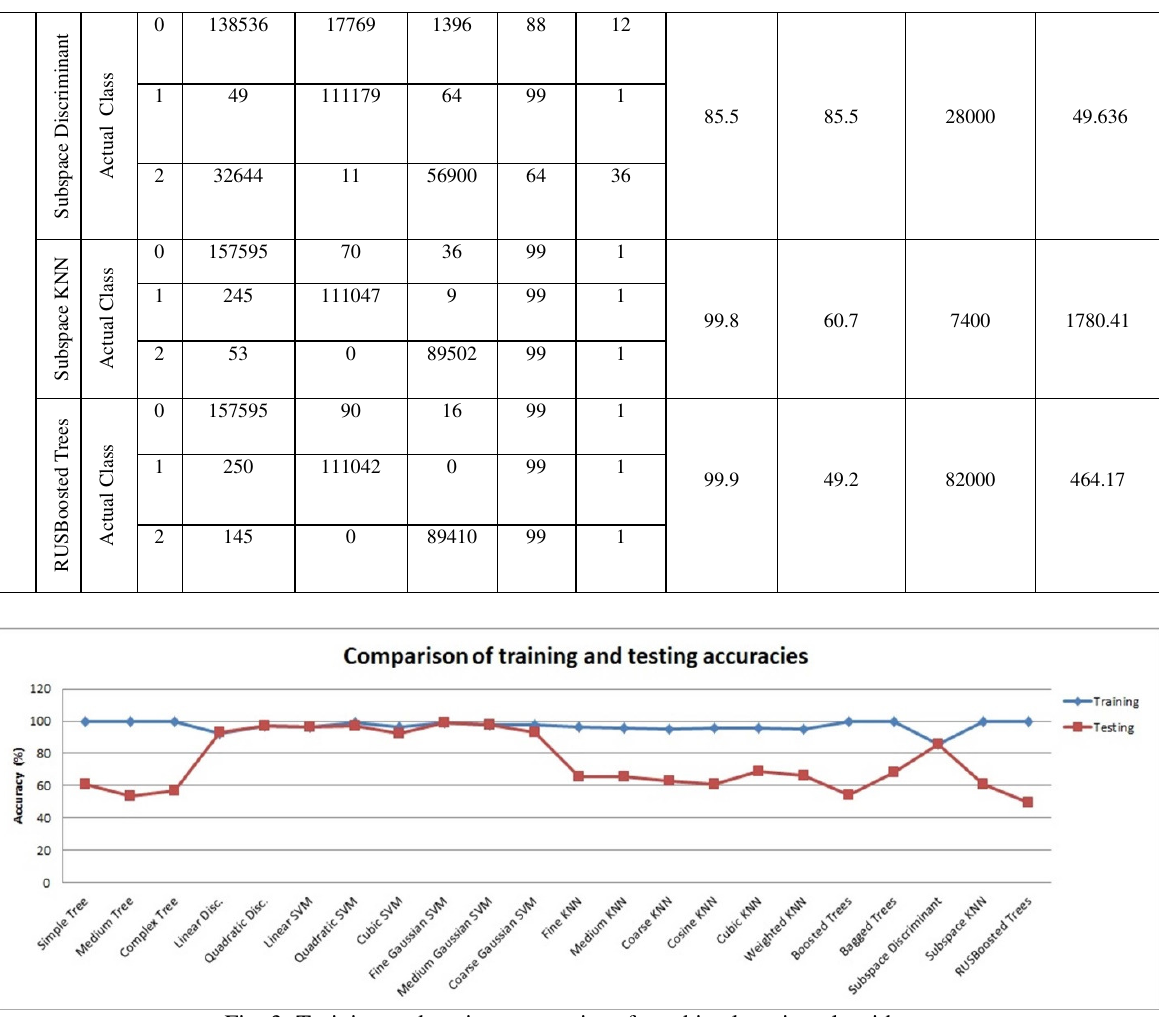
Fig. 3: Training and testing accuracies of machine learning